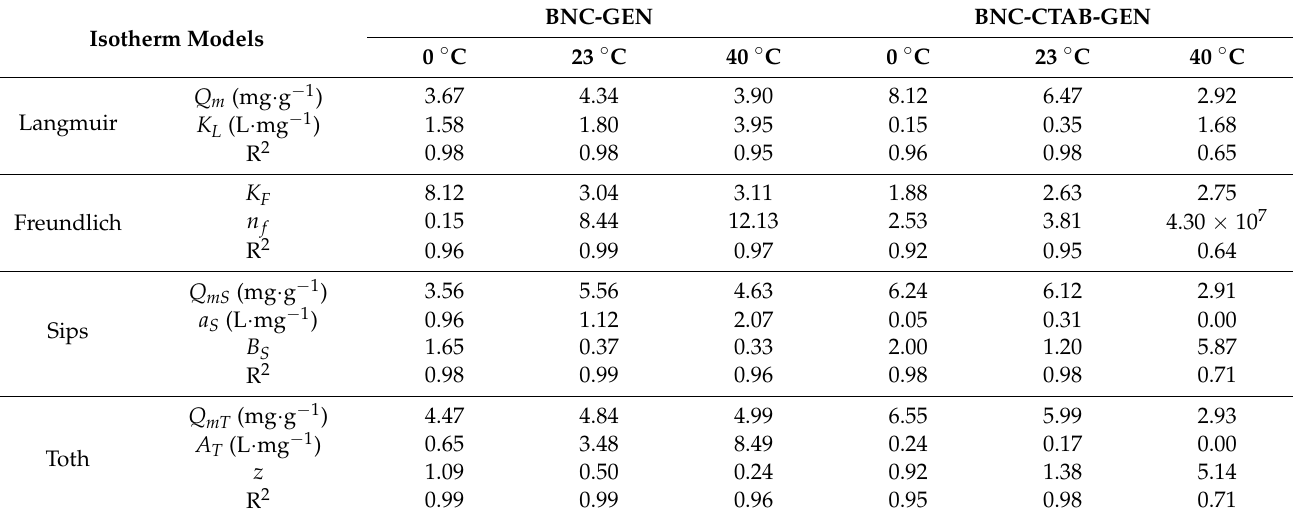
Table 1. Isotherms models for genistein adsorption in BNC and BNC-CTAB. Isotherm